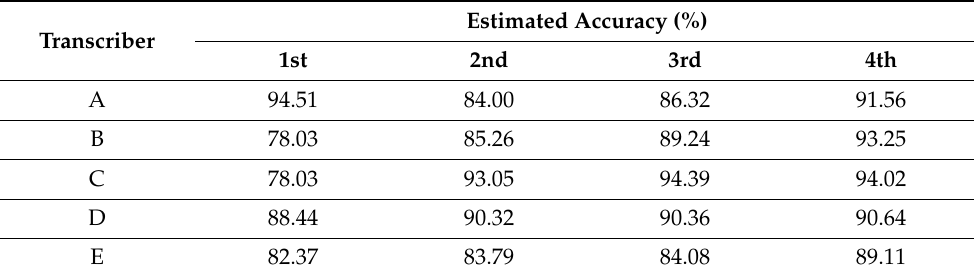
Table 6. Estimated annotation accuracy of an individual